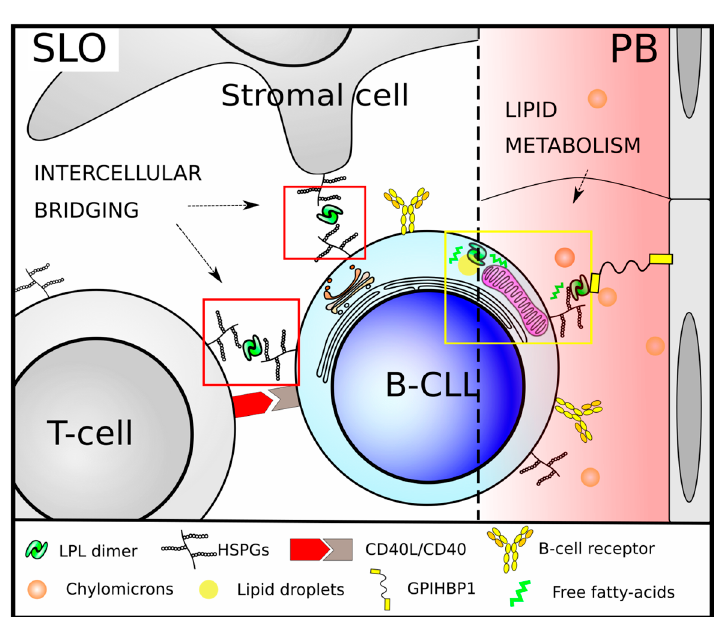
Figure 1. Hypothetical model of LPL function in CLL B-cells in secondary lymphoid organs (SLO, left) and peripheral blood (PB, right). HSPG-attached LPL molecules at the surface of B-CLL cells can bind very low-density lipoproteins and chylomicrons thus contributing to oxidative metabolism and fatty-acid signaling. LPL has been proposed to play a similar role in the intracellular compartment by releasing FFAs from cytosolic lipid droplets [36,56]. A non-canonical role for LPL in CLL B-cell surface would contribute to microenvironmental crosstalk. LPL would act as a bridging molecule between cells able to bind LPL either by heparan sulfate proteoglycans or GPIHBP1, thus facilitating modulatory interactions, exemplified here by a T-cell dependent activation through CD40/CD40L interaction.